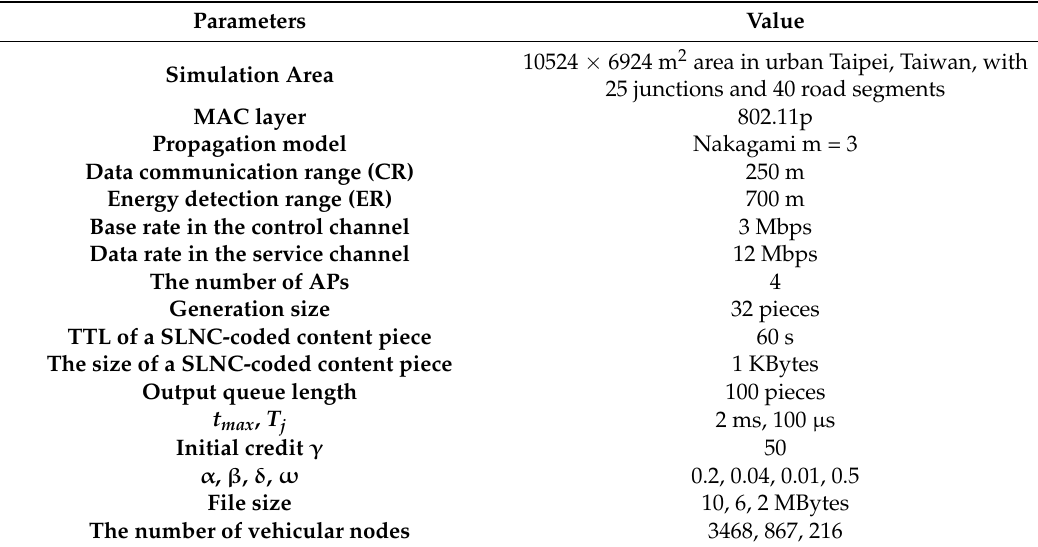
Table 4. Simulation parameters and their